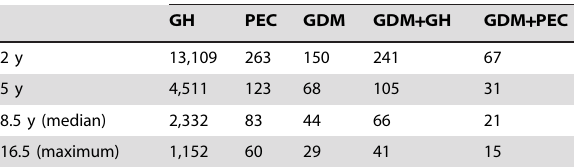
Table 3. Number needed to follow.